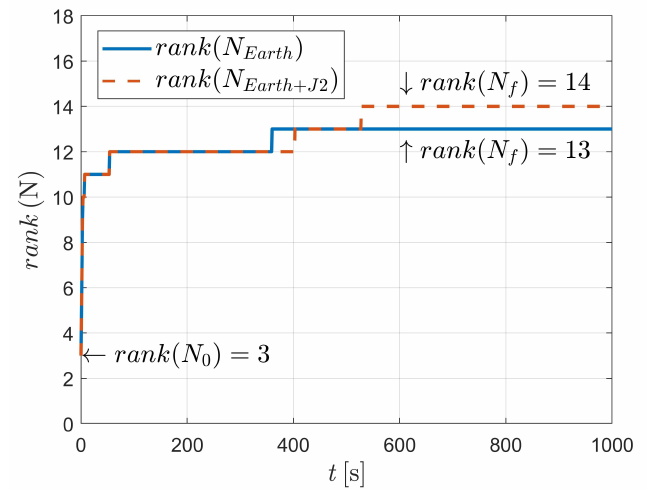
Figure 8. Observability simulation of case III (nonperturbation and with J 2 perturbation).